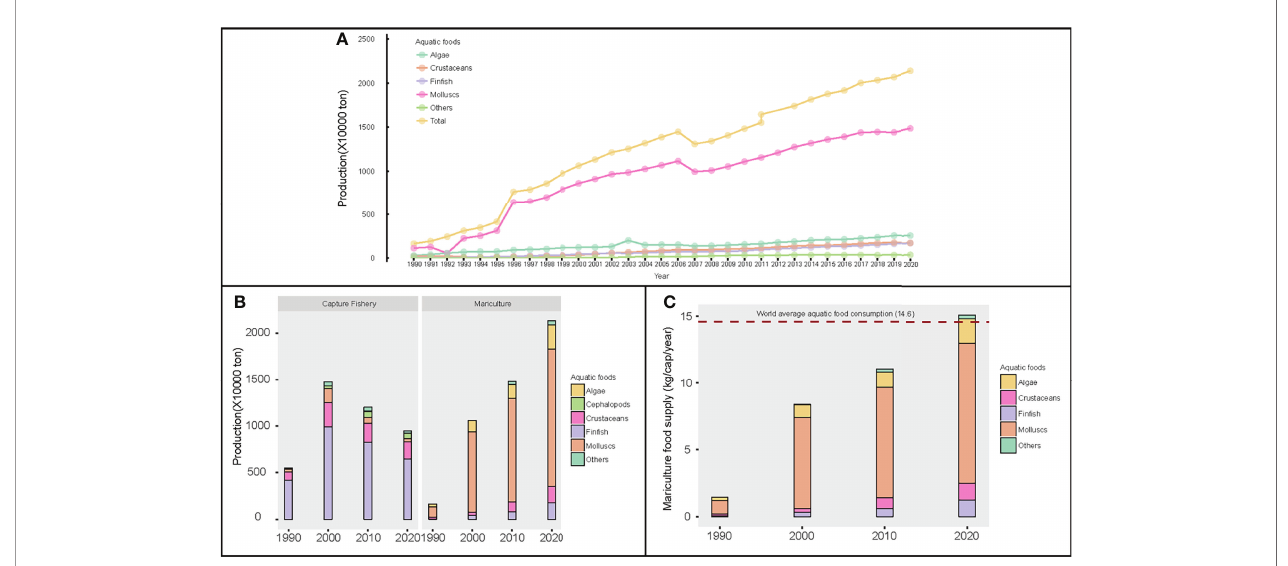
FIGURE 1 | Food supply function of mariculture in China. (A) The total and selected group mariculture production of China between 1990 and 2020. (B) The production and comparison between capture fi shery production and mariculture production of China in 1990, 2000, 2010, and 2020. (C) . Per capita aquatic food consumption for selected groups (kg/cap/year) in China. China demonstrates a high level of edible mariculture product per capita in relation to global edible aquatic consumption (14.6 kg/cap/year, including freshwater and marine aquatic foods). By 2020, China ’ s mariculture food supply alone is higher than the world ’ s average aquatic